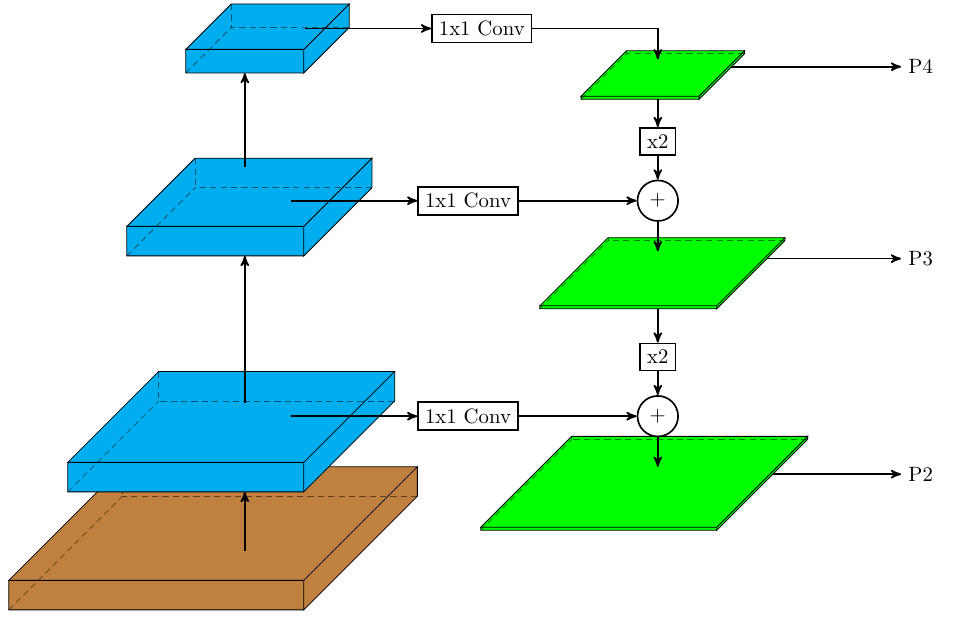
Figure 3. The structure of a feature pyramid network. The bottom-up pathway is a deep convolutional network. The top-down pathway combines semantically-strong features with more accurately-localized features via lateral